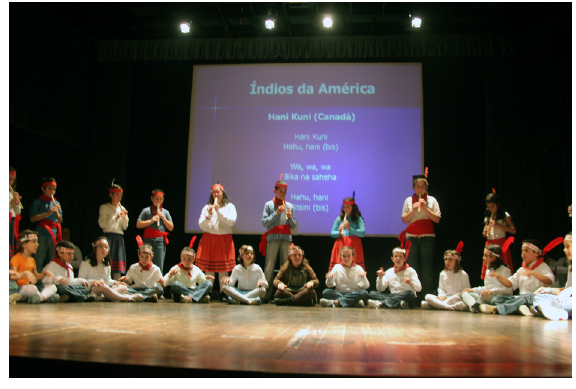
7 | Fig. 7: 4th and 6th graders playing together the Ca- nadian Indian song Hani